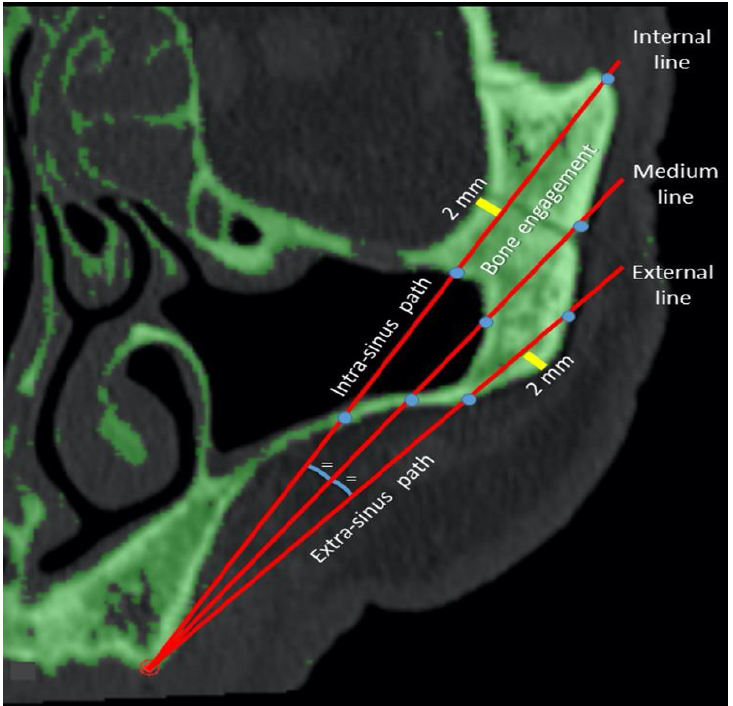
Figure 3. Measurements of the intra- and extra-sinus pathways and bone engagement on the internal, intermediate, and external possible trajectories. Lines 1, 2, and 3 are the internal, intermediate, and external trajectories respectively .